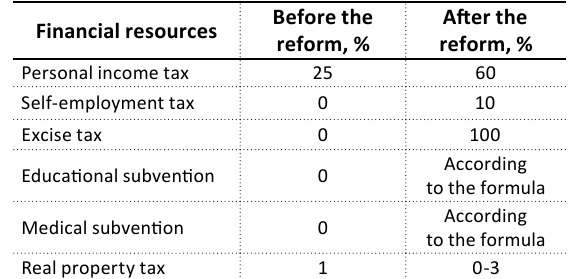
Table 1. The tax base of the UTC budgets before and after decentralization